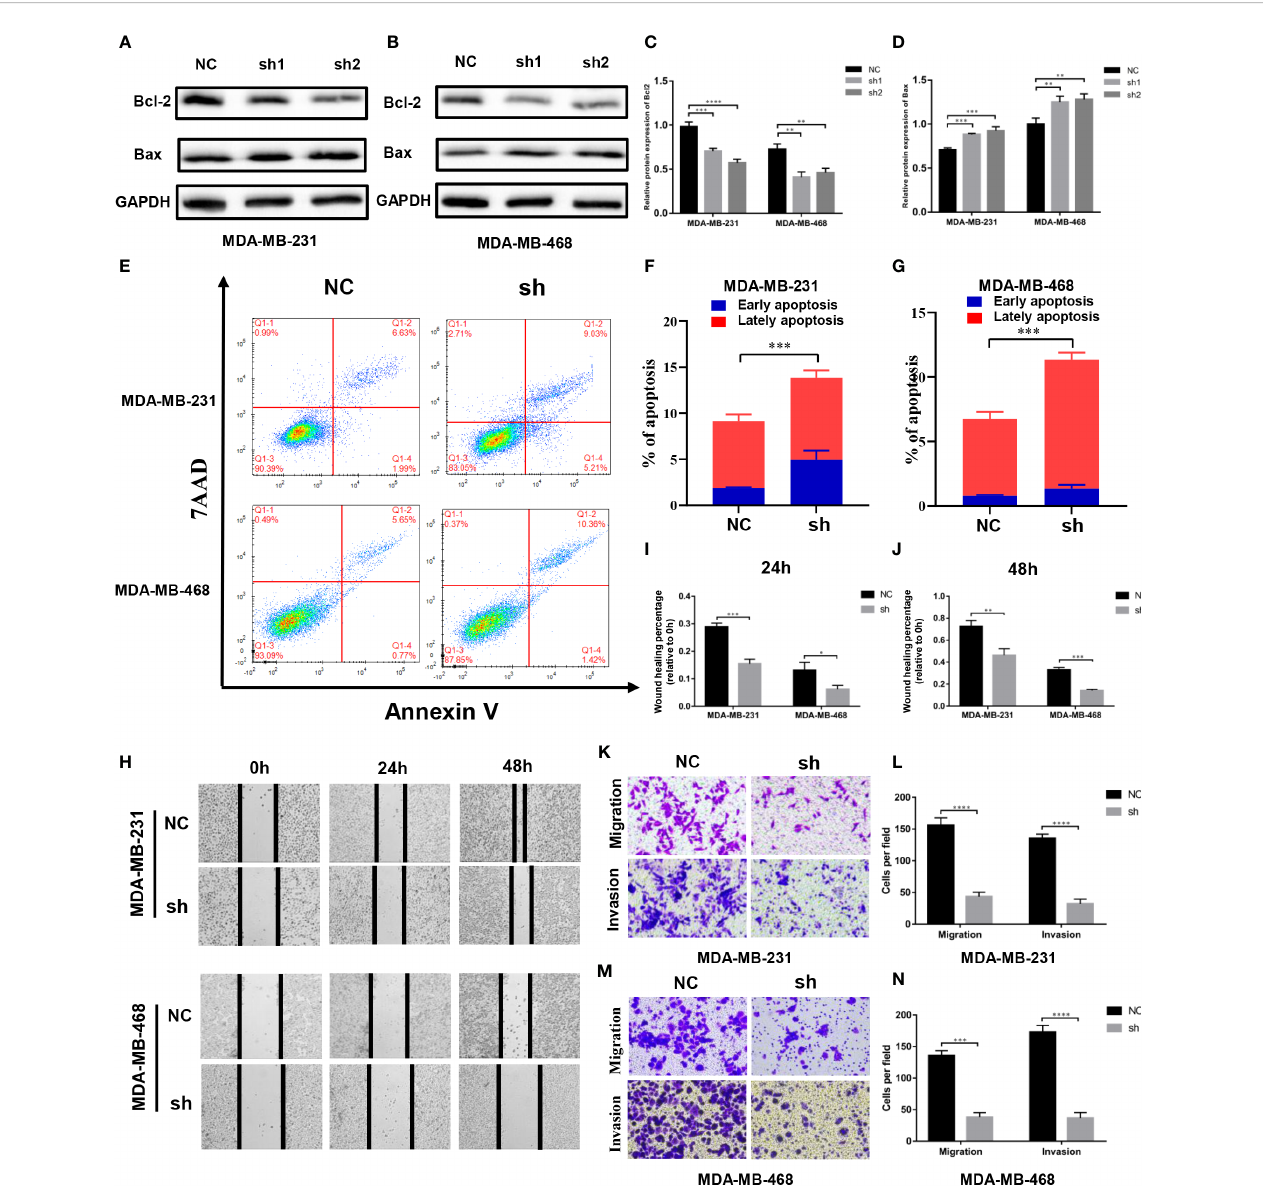
FIGURE 9 Effect of MTHFD2 knockdown on apoptosis, migration, and invasion in TNBC cell. (A – D) Western blot assays were used to verify the expression of Bcl2 and Bax in MTHFD2-knockdown MDA-MB-231 and MDA-MB-468 cell lines. (E – G) The effect of MTHFD2 knockdown on apoptosis in MDA-MB-231 and MDA-MB-468 cell lines (measured by fl ow cytometry). (H – J) Effect of MTHFD2 knockdown on migration in MDA-MB-231 and MDA-MB-468 cell lines (measured by wound scratch assay). (K – N) Effect of MTHFD2 knockdown on migration and invasion in MDA-MB-231 and MDA-MB-468 cell lines (measured by transwell assay). (ns: p ≥ 0.05, * p <0.05, ** p <0.01, *** p <0.001, **** p